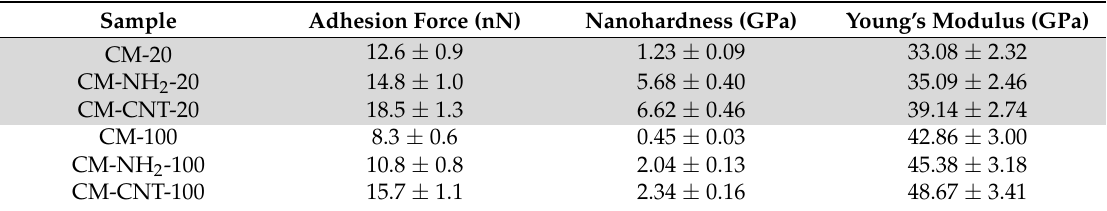
Figure 9. AFM imaging of membrane 2D and 3D topography and cross-section of samples: ( A ) pristine (CM-100); ( B ) after first stage of functionalization with anime groups (CM-NH 2 -100); ( C ) after second stage of functionalization with CNT (CM-CNT-100). Table 1. Tribological characterization of pristine and functionalized ceramic